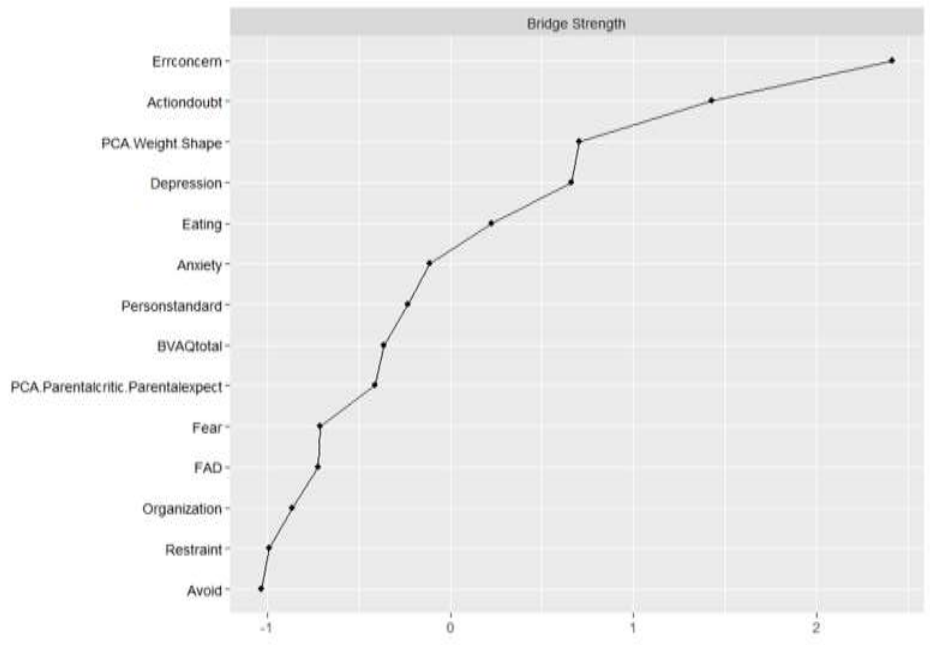
Figure 4. Bridge strength plot. Errconcern: Concern over Mistakes, Actiondoubt: Doubt about Actions, PCA.WeightShape: Overvaluation of Weight and Shape, PersonStandard: Personal Standards, BVAQ total: Alexithymia total score, PCA.Parentcritic.ParentExpect: Parental Criticism and Expectations, FAD: Family Assessment Device.